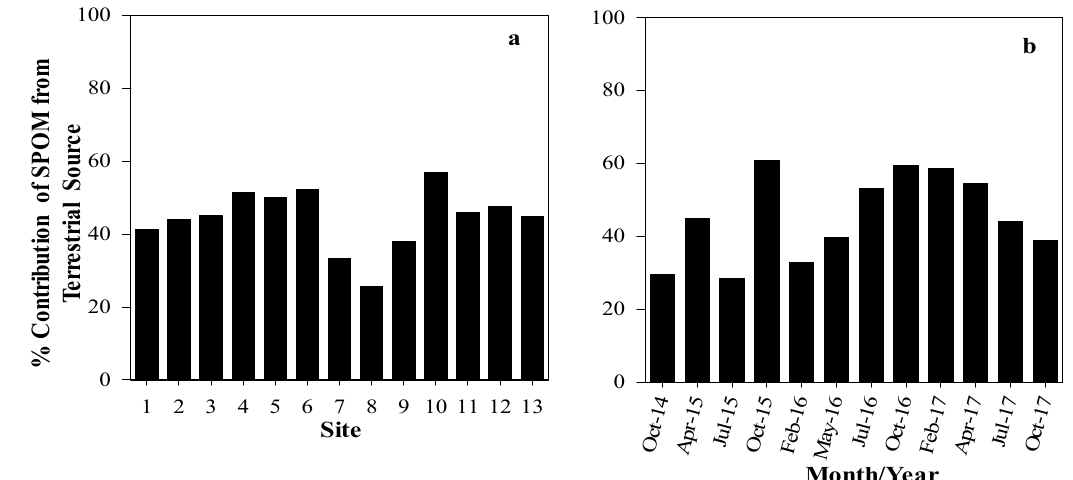
Figure 8. Spatial ( a ) and temporal ( b ) patterns of contributions of SPOM from terrestrial sources in the Maryland Coastal Bays.